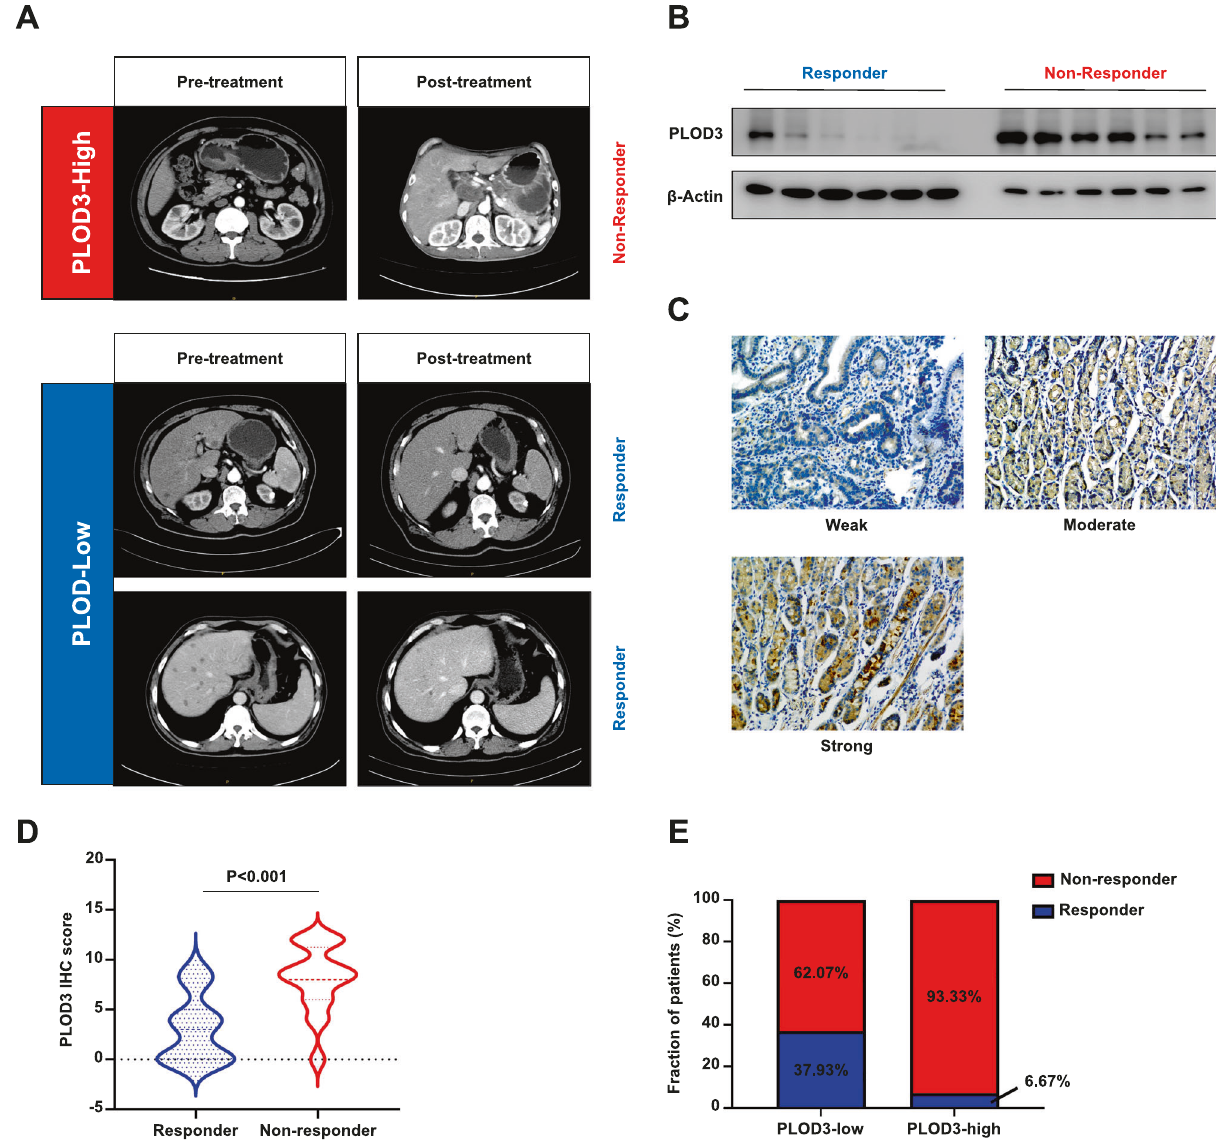
Fig. 3 The expression of PLOD3 is associated with Trastuzumab effectiveness in HER-2 positive GC patients. A Representative images of Patients with distinct PLOD3 expression as well as the response to Trastuzumab were shown. B The protein levels of PLOD3 in responder and nonresponder GC patients receiving Trastuzumab were assessed by western blot. C Representative images of IHC staining for PLOD3 in clinical GC samples. D IHC score of PLOD3 in GC patients receiving Trastuzumab. E Response rate of gastric cancer patients with different PLOD3 expression status to trastuzumab